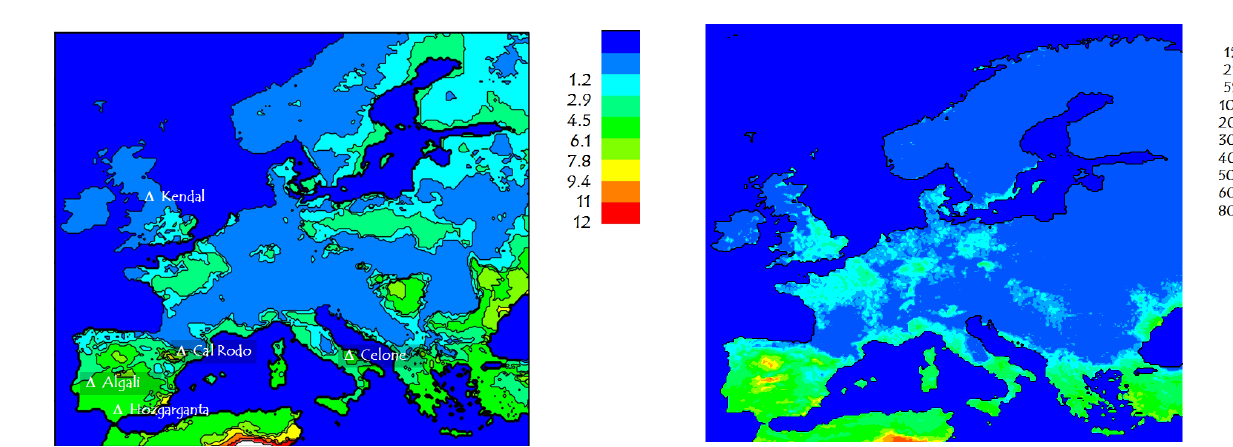
Fig. 7. Percentage of time with low flow “pool” conditions, derived from monthly duration curves with 2 ◦ C